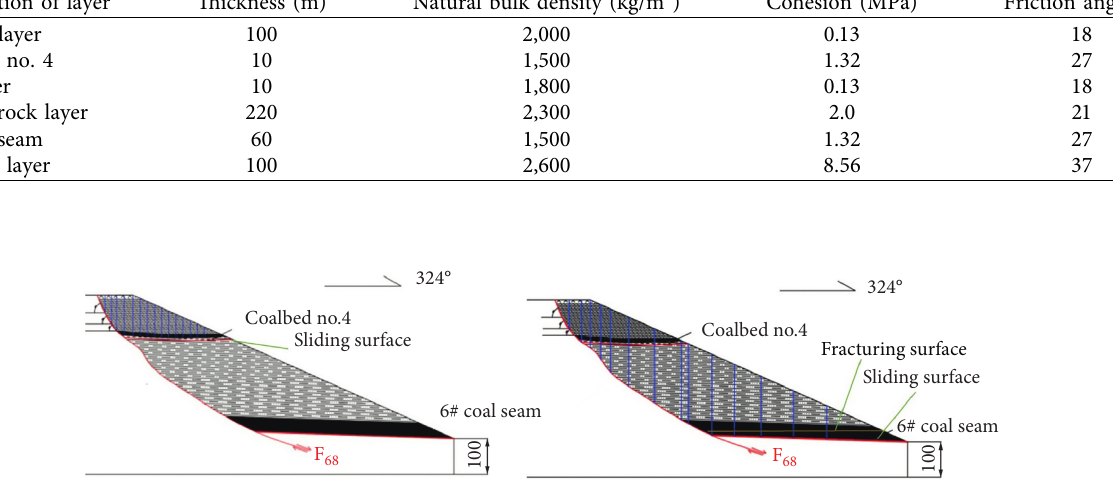
Figure 16: Sketch maps of stability calculation of all slide blocks.